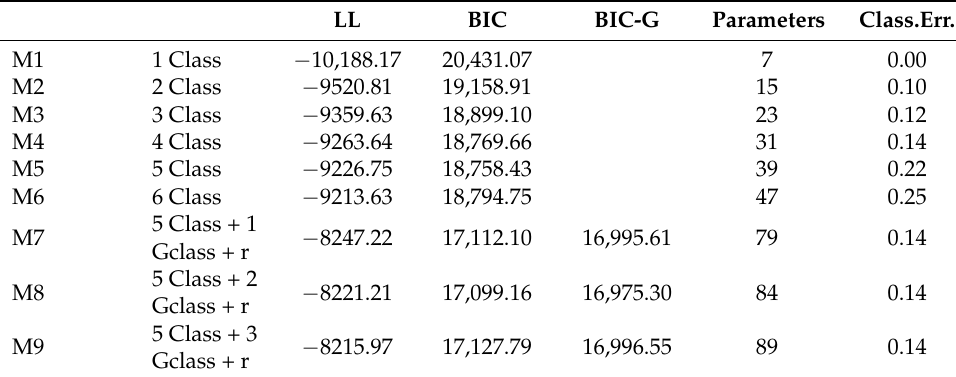
Table A1. Goodness-of-fit statistics for multilevel latent class models.